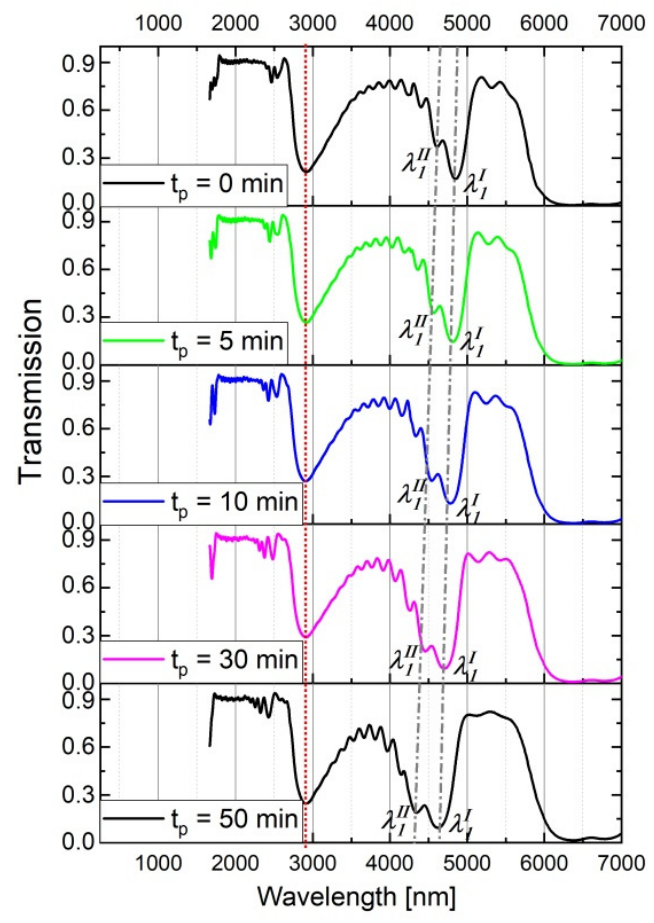
Figure 10. Transmission spectra of the PAA_3653-1535 for different t p .